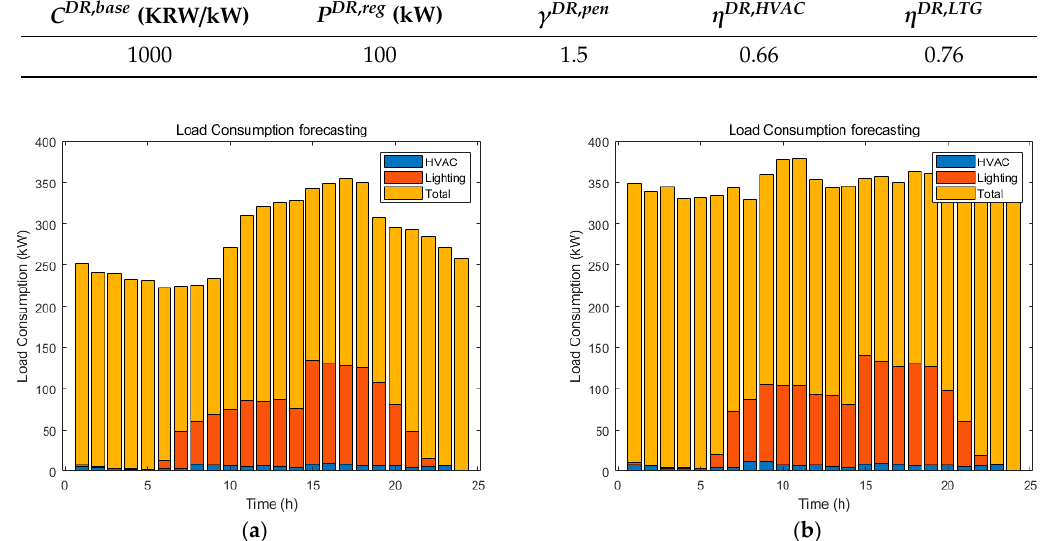
Figure A2. Load consumption of heating, ventilation, and air conditioning (HVAC) and lighting (LTG) data: ( a ) 14 August 2017 (summer); ( b ) 25 January 2017 (winter).